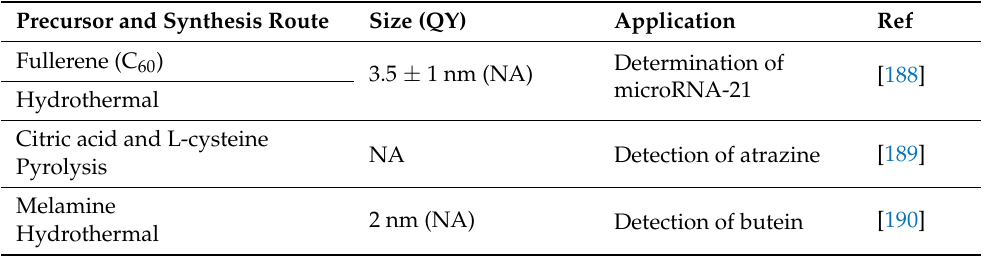
Table 6. Carbon dot-based electrochemiluminescence detection. Precursor and Synthesis Route Size (QY) Application